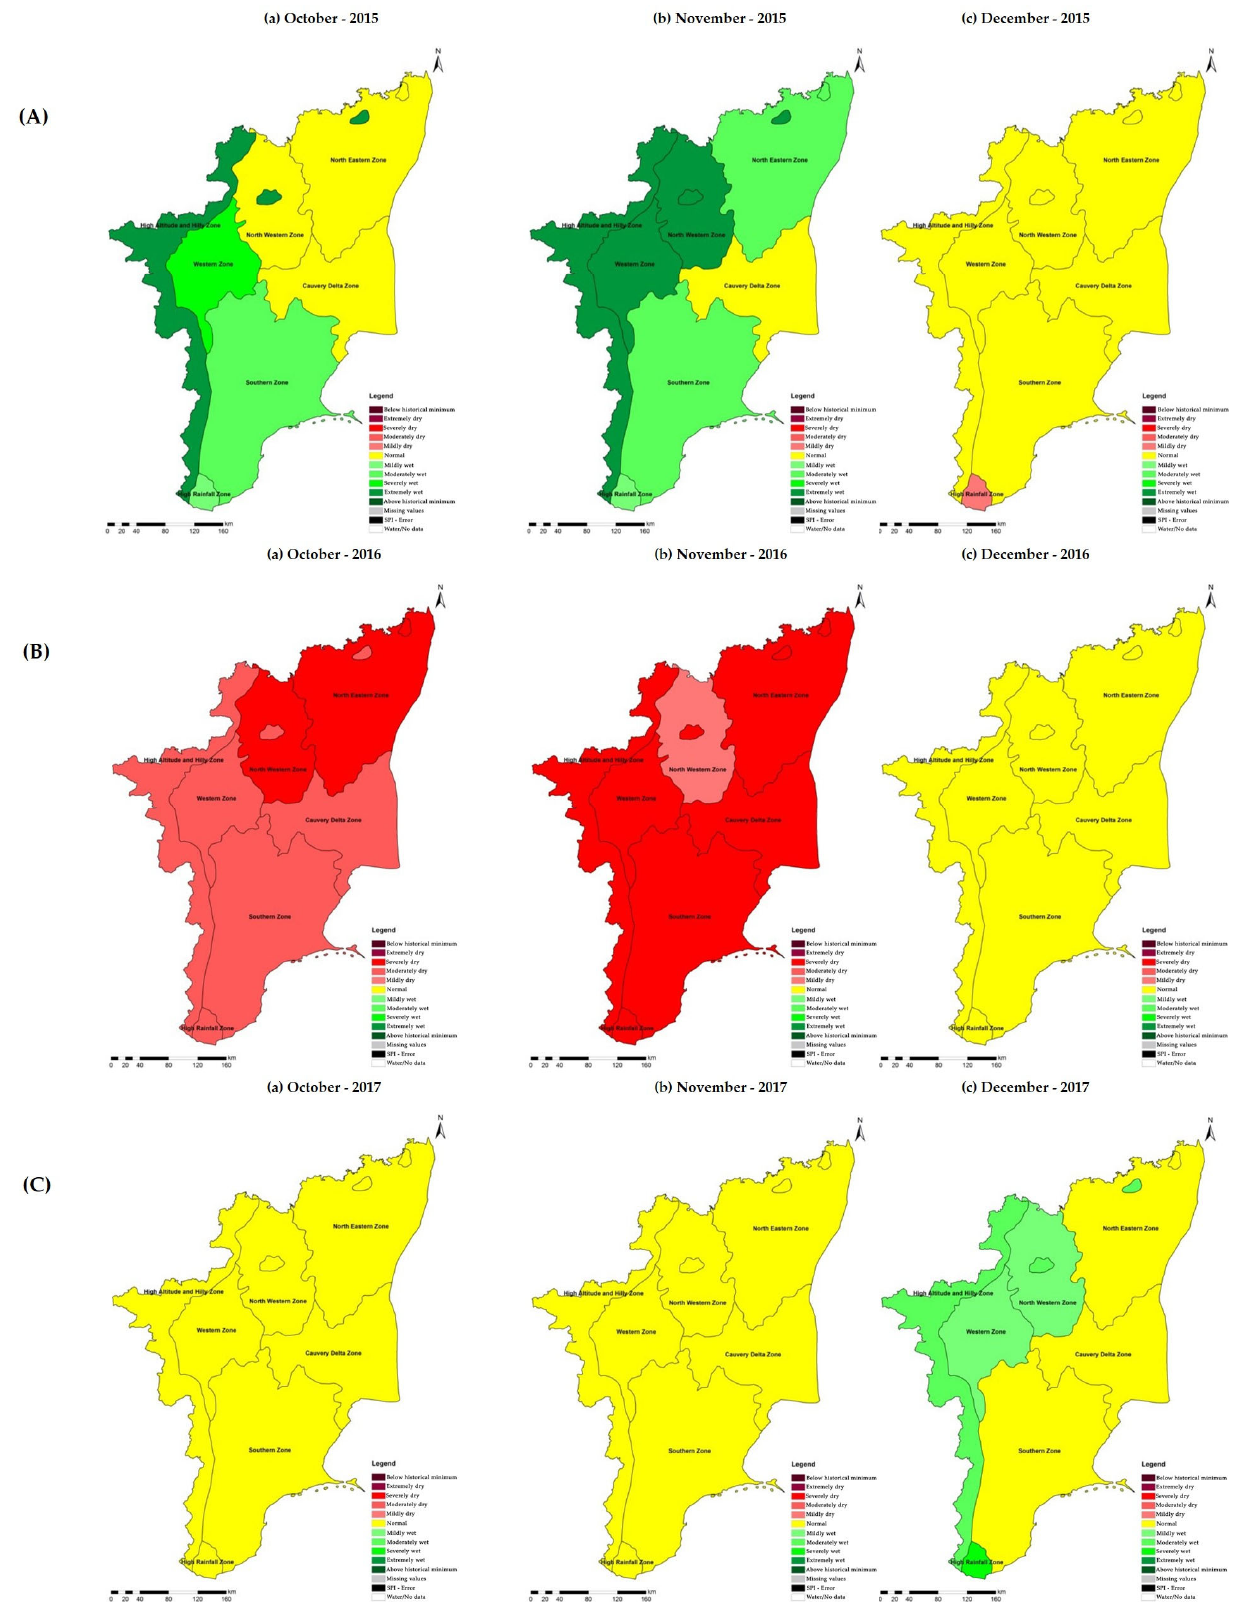
Figure 7. Agro-climatic zone-wise SPI of spatial distribution for rainfall departure during ( A ) 2015, ( B ) 2016, and ( C ) 2017.